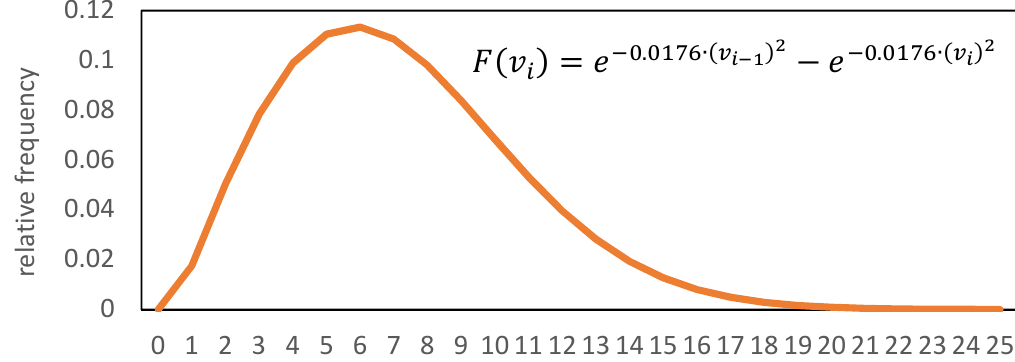
Figure 2. Relative frequencies of occurrence for various wind speeds used for load duration calculation.